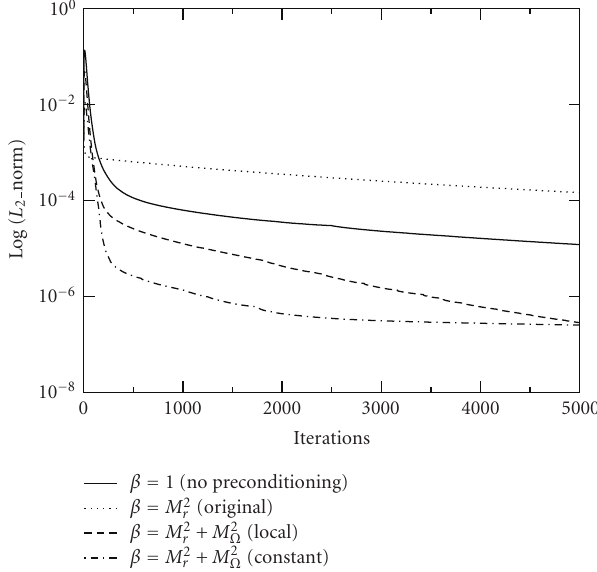
Figure 3: Convergence histories of di ff erent preconditioning options on a rotating flow.